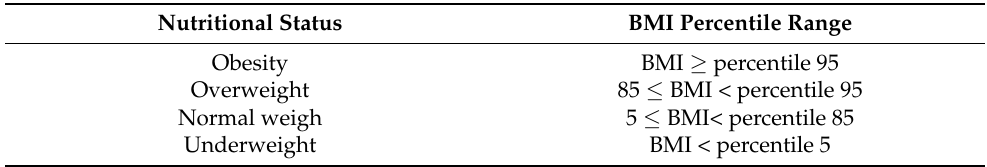
Table 1. Body mass index (BMI) percentile, indicator of the nutritional status of children aged 2 to 20 years (CDC, 2000)